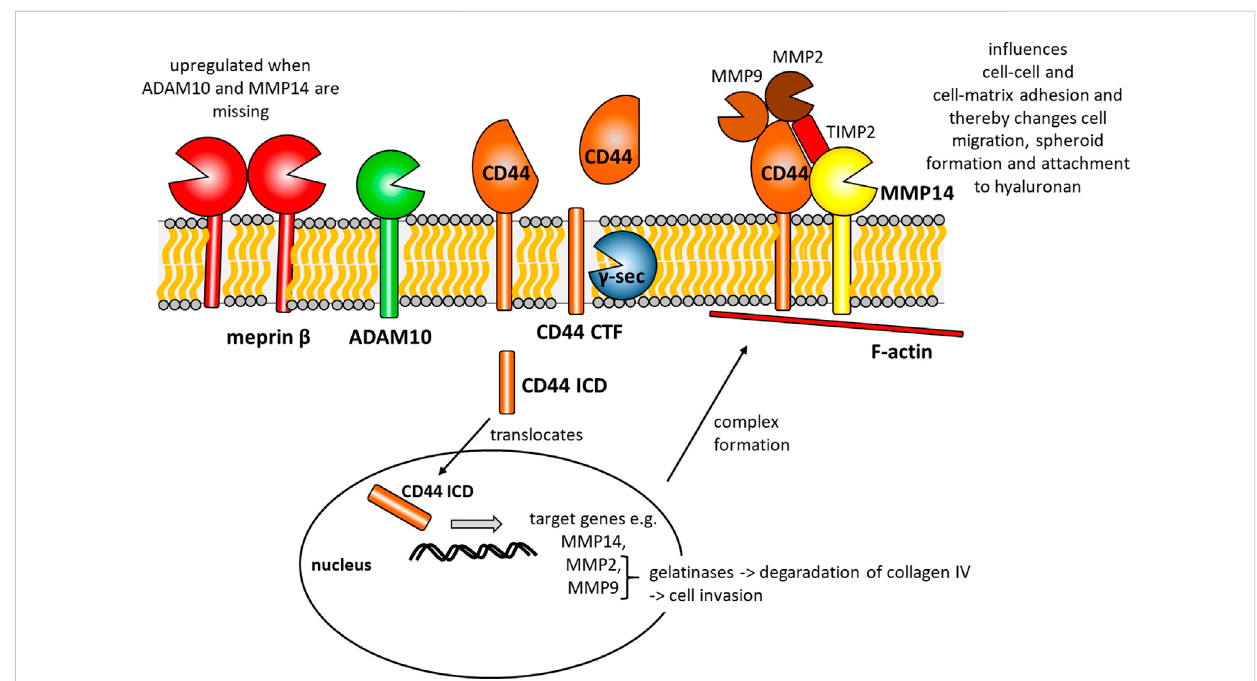
FIGURE 5 Summarizing cartoon of our fi ndings combined with data published by other groups before. CD44 is cleaved by ADAM10 to generate a CD44 C- terminal fragment (CD44 CTF). This CTF is then prone to y-secretase (y-sec) cleavage within the membrane, which generates a CD44 intracellular domain (CD44 ICD). This ICD translocatesto thenucleus and inducestheexpression ofe.g. MMP14, MMP2 andMMP9.At thecell surfaceCD44, MMP14,